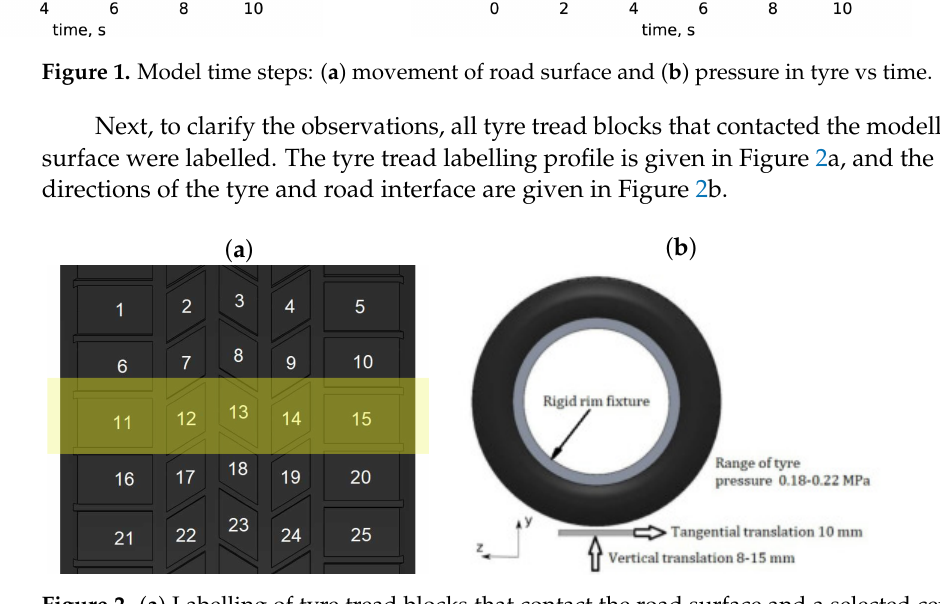
Figure 2. ( a ) Labelling of tyre tread blocks that contact the road surface and a selected centre line. ( b ) Movement directions of model